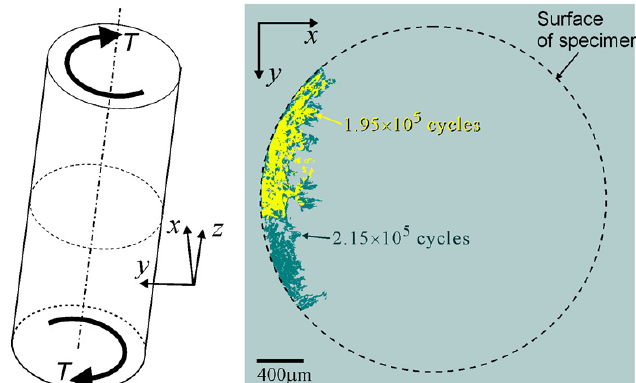
Figure 2: 3D rendering of a crack perpendicular to the sample axis similar to the one shown in Fig. 1 at two different numbers of cycles.(195k cycles and 215k